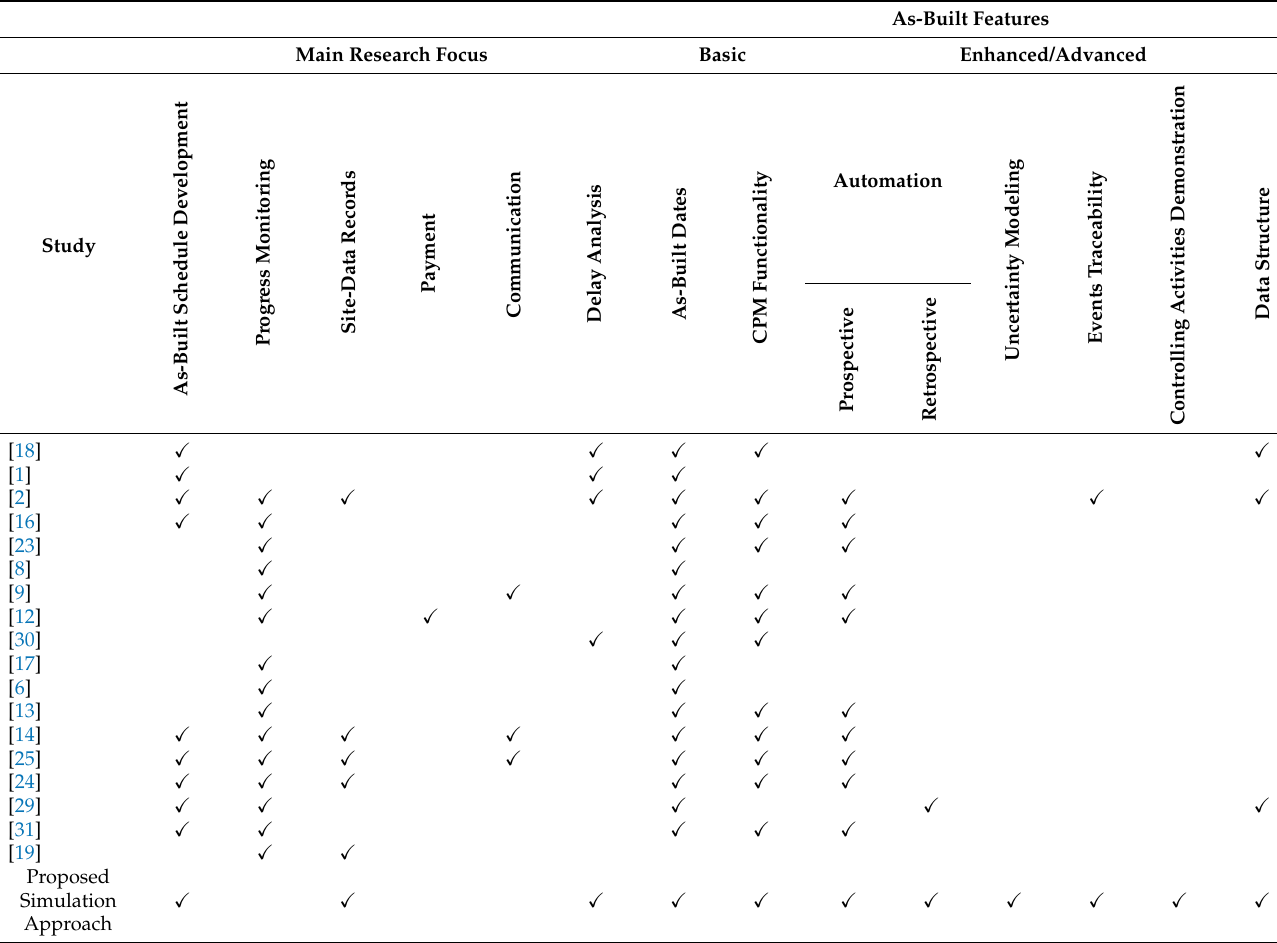
Table 1. Summary of previous studies.